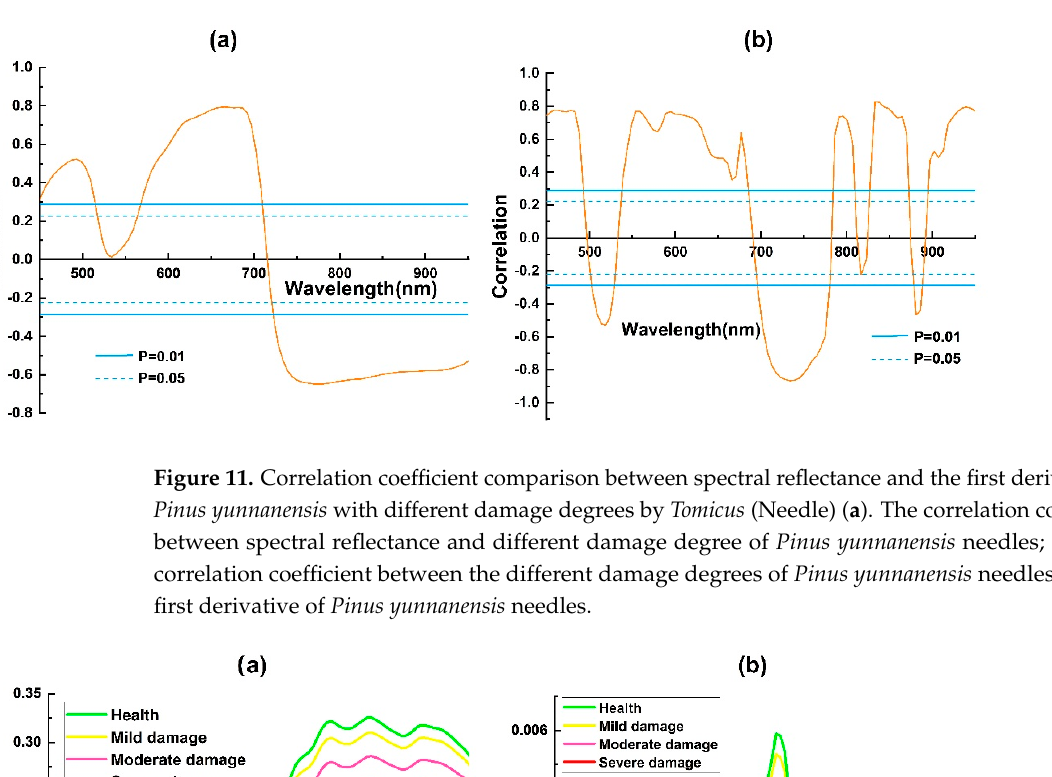
Figure 12. Comparison of sensitive bands of spectral reflectance and the first derivative of Pinus yunnanensis with different damage degrees by Tomicus (Needle) . ( a ) Spectral reflectance of the nee- dle; ( b ) Spectral first derivative of the needle.